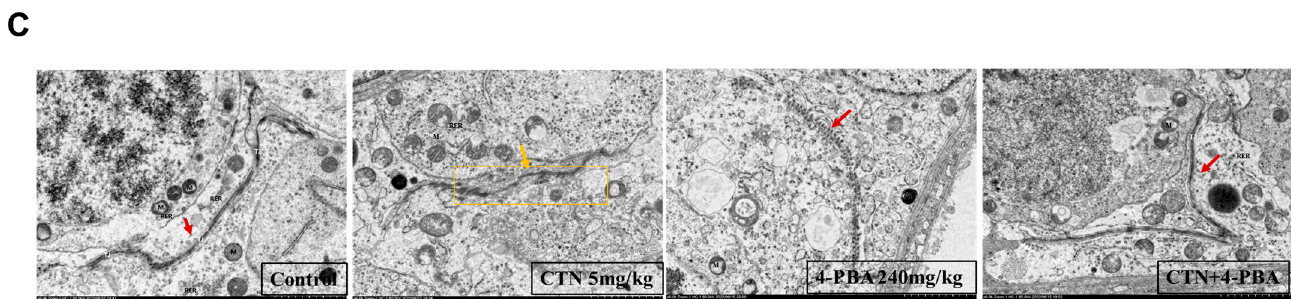
Figure 8. Effects of 4-PBA on CTN-induced BTB damage in mice. ( A ) Occludin and claudin-1 protein expression levels; ( B ) ZO-1 immunofluorescence; ( C ) Ultrastructural observation of testicular tissue (Red: TJ; yellow: TJ destruction; M: mitochondria; RER: endoplasmic reticulum; scale bar: 2 µm. The above data are expressed as SEM ± mean, ** p < 0.01, compared with the control group, # p < 0.05, ## p < 0.01, compared with the CTN group.